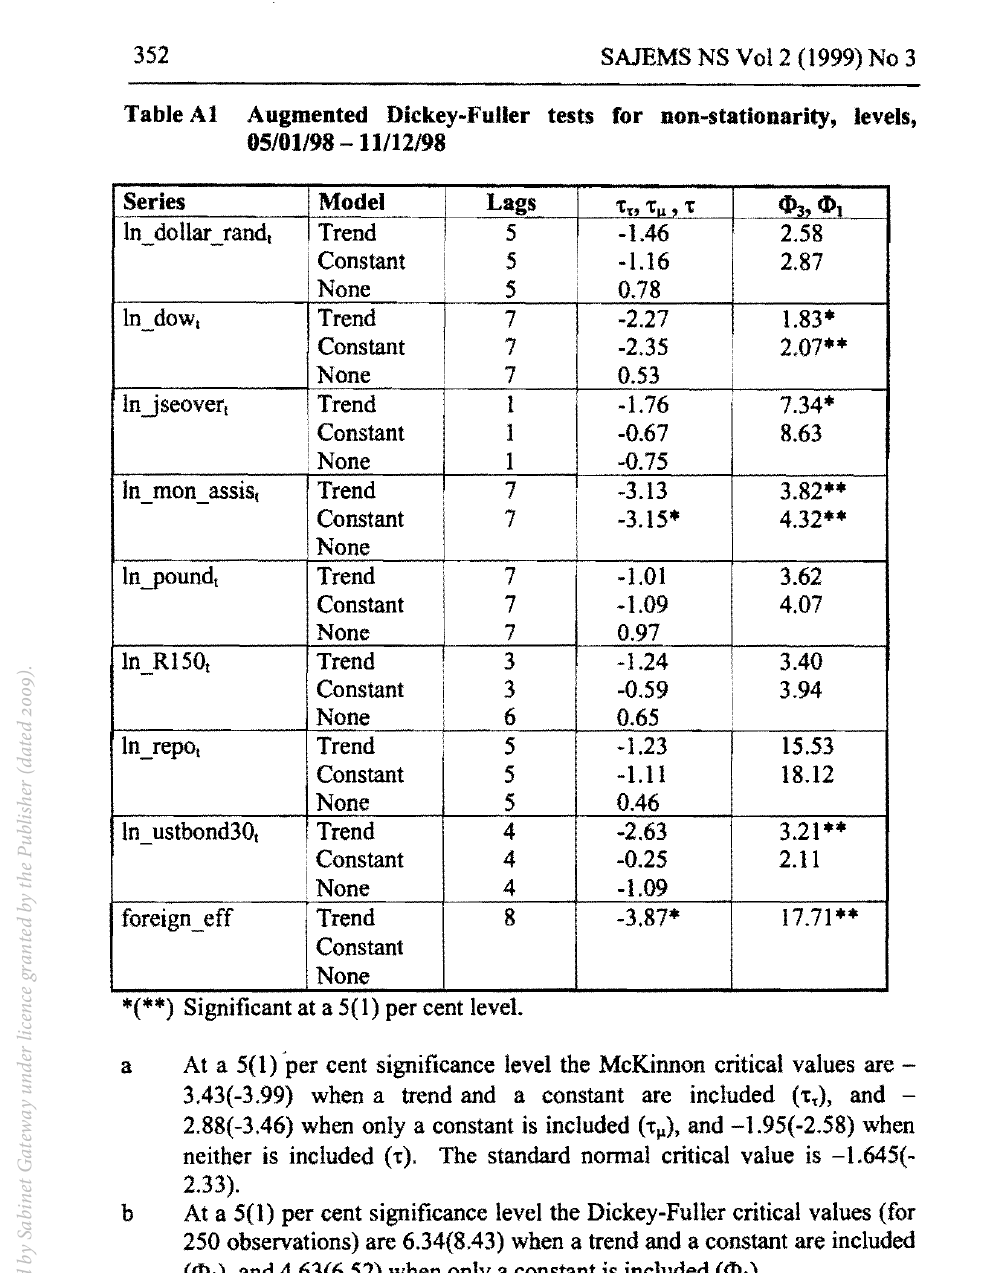
Augmented Dickey-Fuller tests for non-stationarity, levels, 05/01/98